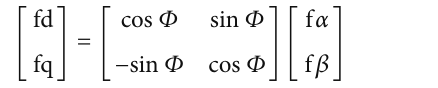
Figure 4: Input membership function for current error.